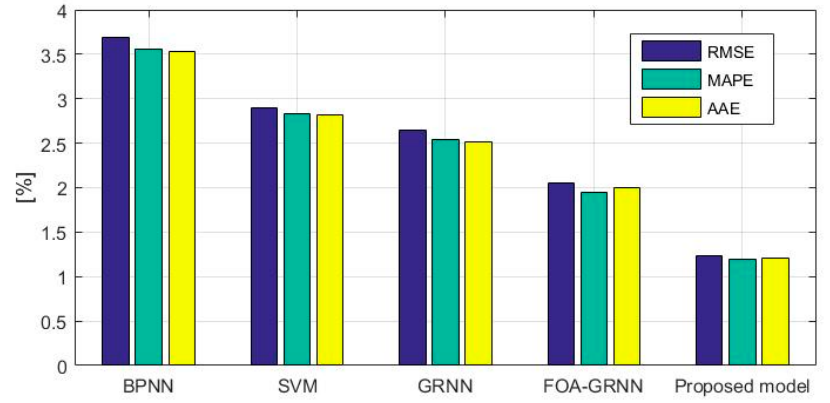
Figure 8. Values of root-mean-square error (RMSE), mean absolute percentage error (MAPE) and average absolute error (AAE). Table 3. Part of the forecasting value and relative errors of each model.